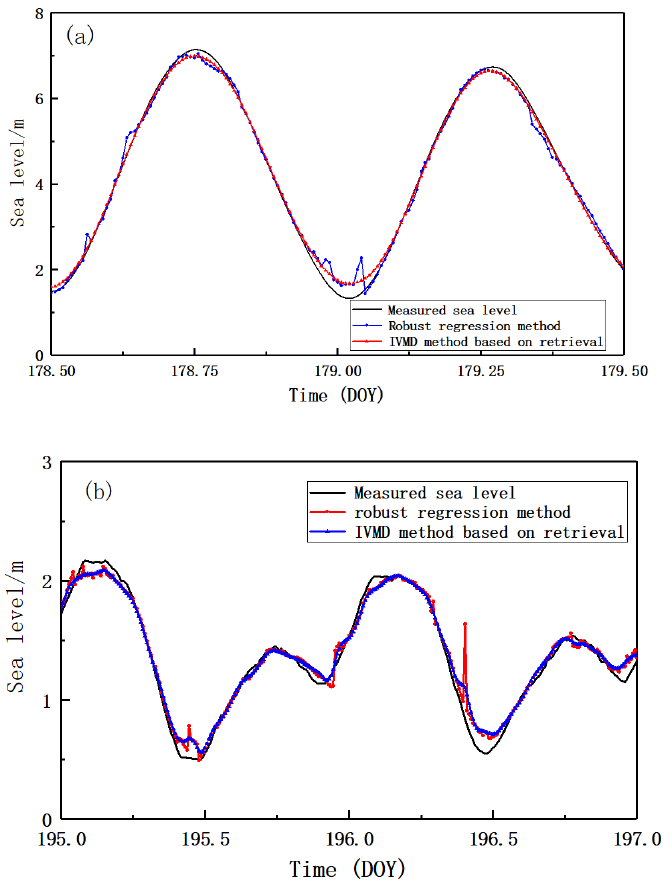
Figure 8. Comparison of the result of stations retrieval: ( a ) comparison between the results of robust regression and IVMD algorithm for the BRST station during DOY 177–191, 2021; ( b ) comparison between the results of robust regression and IVMD algorithm for the HKQT station during DOY 177–191, 2021.